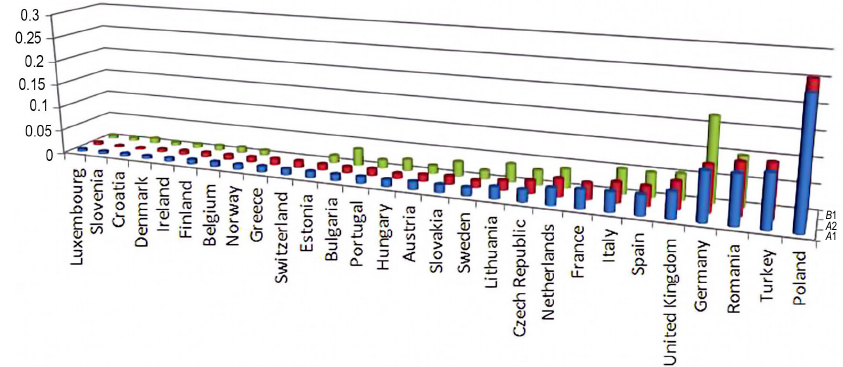
Fig. 2. Ranking weights in the DEA-PC method without the outlier Latvia ( source : own research)